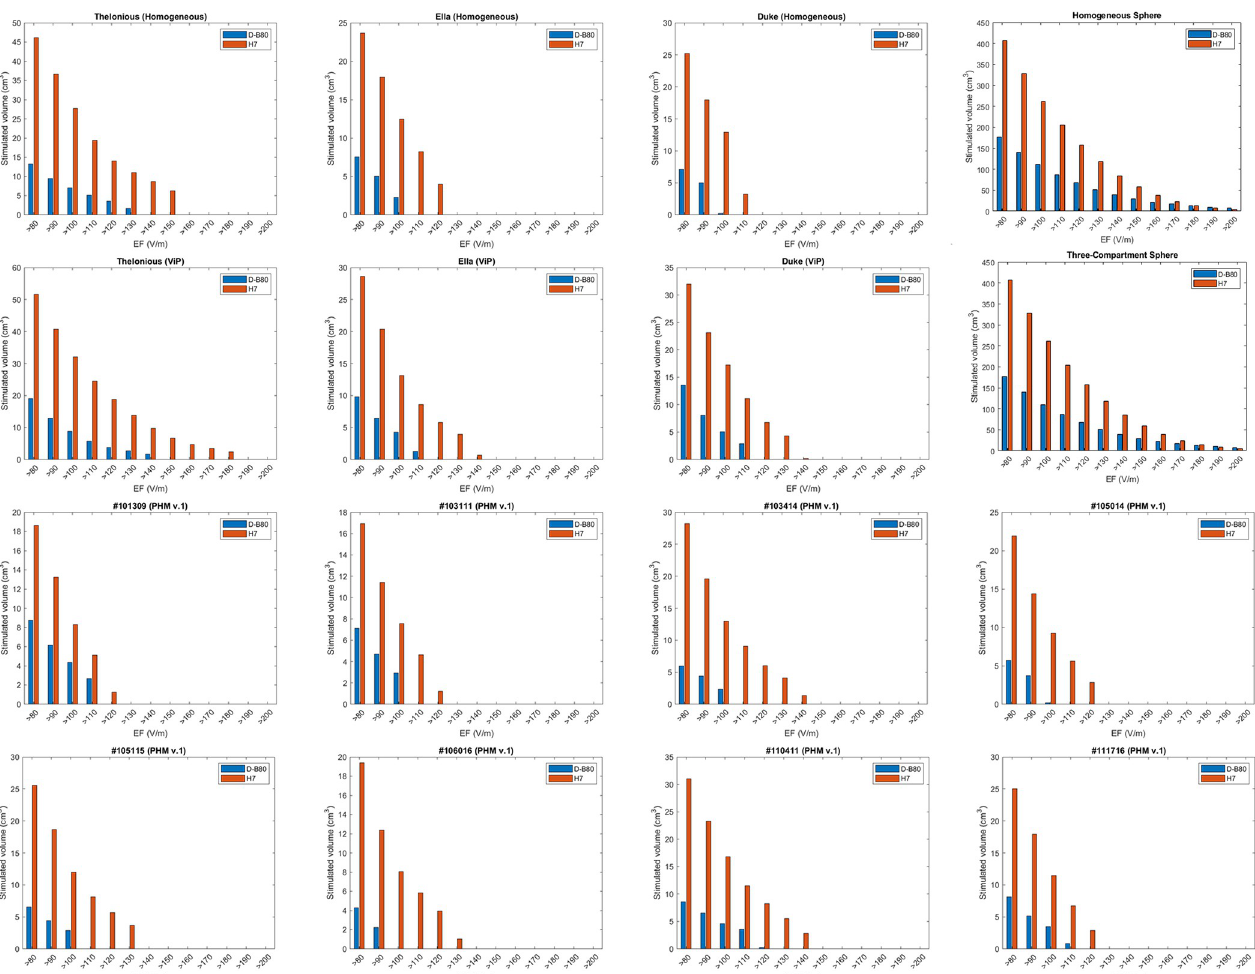
Fig 4. Distribution of values of EF intensity. Histograms of distribution of volume in cm 3 within the brain according to the induced electric field range for the D–B80 and H7 coils. Field columns are in bins of 10 V/m. Results are shown for the 14 numerical head models and the two spherical models.